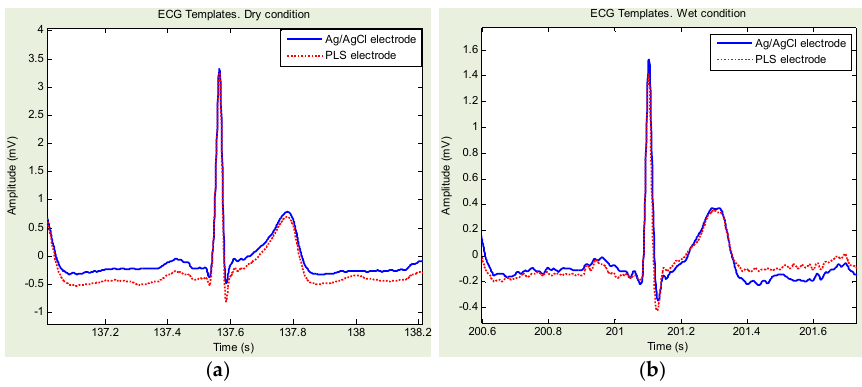
Figure 8. Example of electrocardiogram templates for dry and freshwater wet condition: ( a ) template derived from Figure 6a; and ( b ) template derived from Figure 6d.